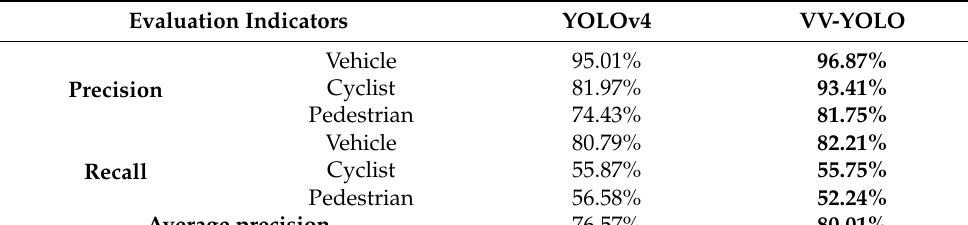
Table 2. Test results of the YOLOv4 model and the VV-YOLO model on the KITTI dataset.